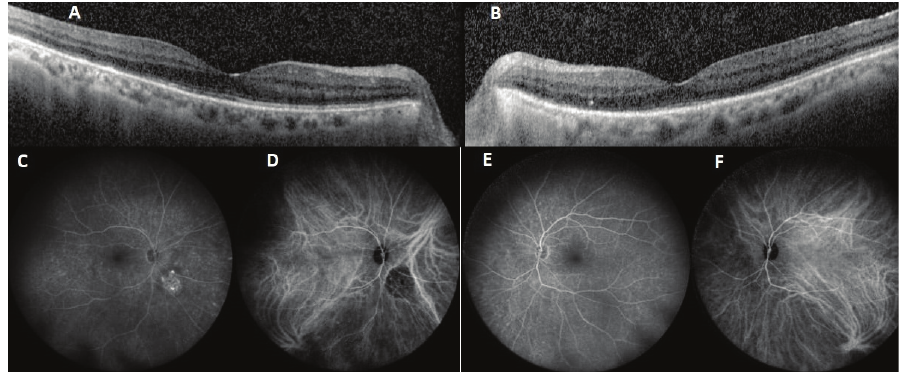
Figure 1. Macular optical coherence tomography (OCT) of right (A) and left (B) eyes, fundus fluorescein angiography (FFA) of the right (C) and left (E) eyes, and indocyanine green angiography (ICGA) of the right (D) and left ((F) eyes. They are all within the normal limit except for an atrophic unrelated lesion inferonasal to the optic nerve head in the right eye.